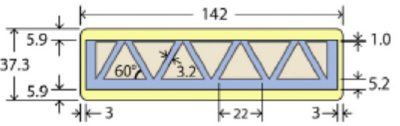
Figure3. SchematicdiagramofthetargetusedinO’Mastaetal.[22]ReproducedfromO’Masta et al.[22], with permission from